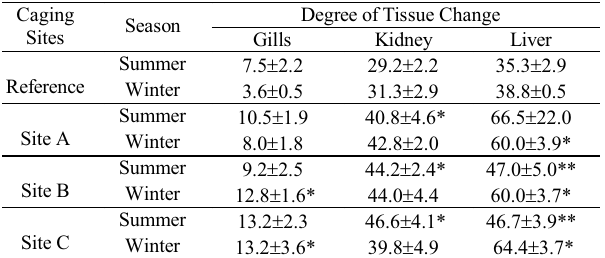
Table 3. Degree of Tissue Change for the gills, kidney and liver of P. lineatus caged at the 3 sites at Cambé stream (A, B and C) and at the reference site, in the winter and the summer. Results are mean ± SE. *indicates statistical difference in relation to the reference site; **indicates statistical differ- ence in relation to winter results ( P <